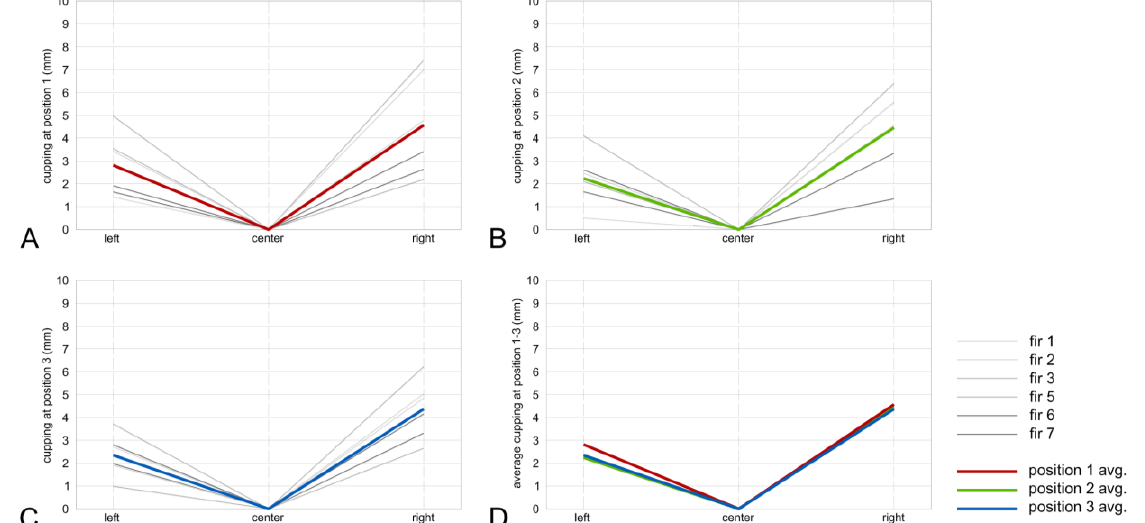
Figure 10. Fir cupping in cutline 1—bottom ( A ), cut line 2—middle ( B ), cut line 3—top ( C ), and all averaged thicknesses ( D ).